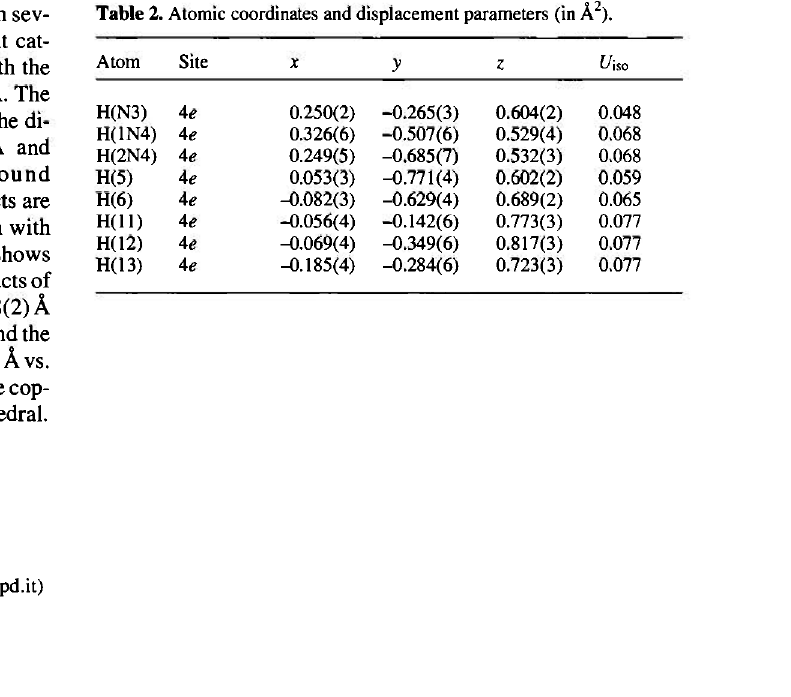
Table 2. Atomic coordinates and displacement parameters (in Ä 2